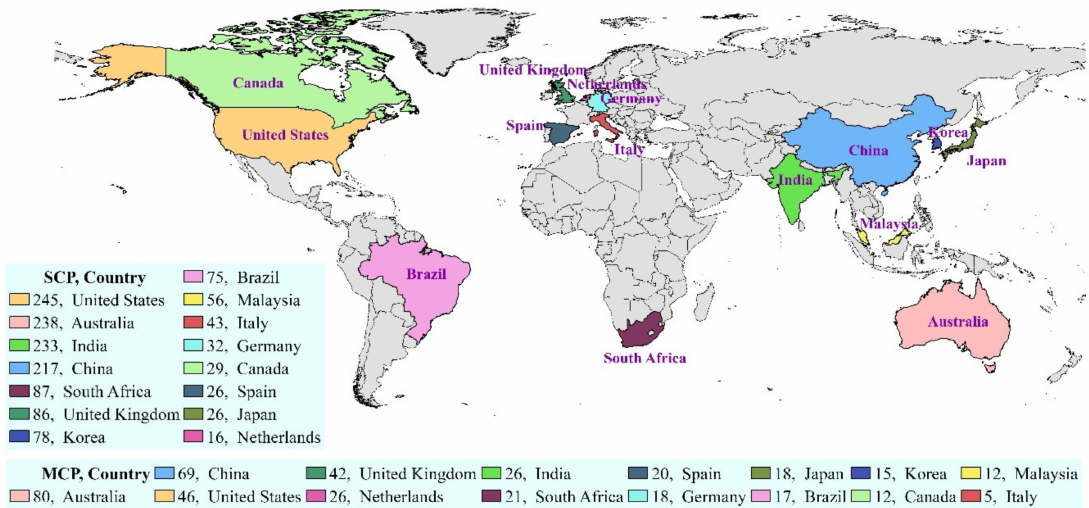
Figure A4. Geographical distribution of single and multiple country publications. SCP presents single country publications whereas MCP presents multiple country